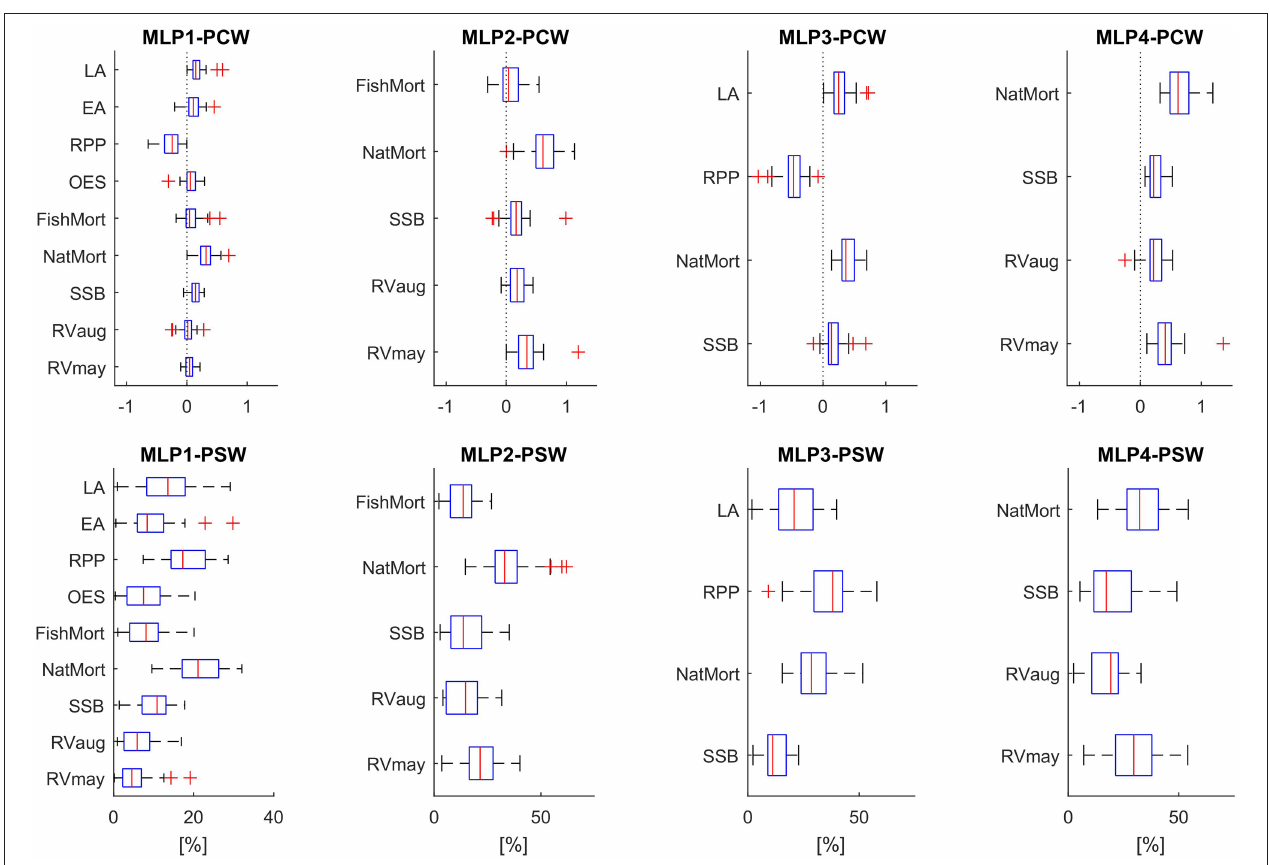
FIGURE 5 | Variable importance based on the PCW and PSW algorithms, for all 5 MLP models. Box plots show the distribution of connection weights within each ensemble member providing a variable importance metric for all model inputs. Red lines mark the median weights, boxes are 75% percentiles, whiskers 2 standard deviations, and red crosses mark the outliers. Top panels show the results obtained using the PCW algorithm, with connection weights in absolute values. Bottom panels show the results obtained using the PSW algorithm, with variable importance given in